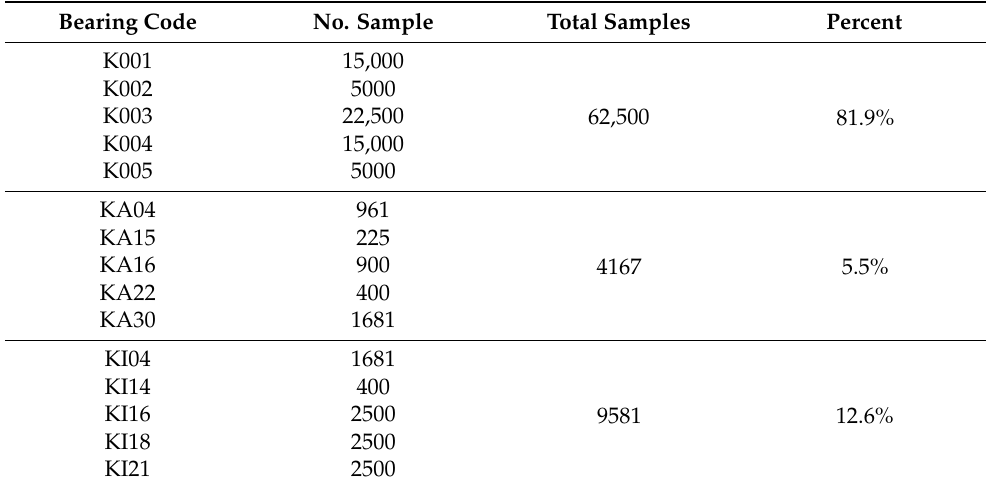
Table 4. Details of N15_M07_F10 image dataset for IFKNMD-CNN. Bearing